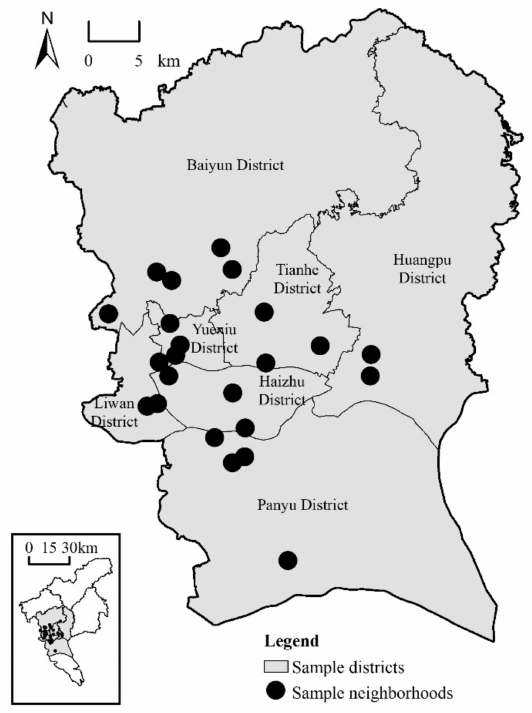
Figure 1. Location of 23 sampled neighborhoods in Ghuangzhou,